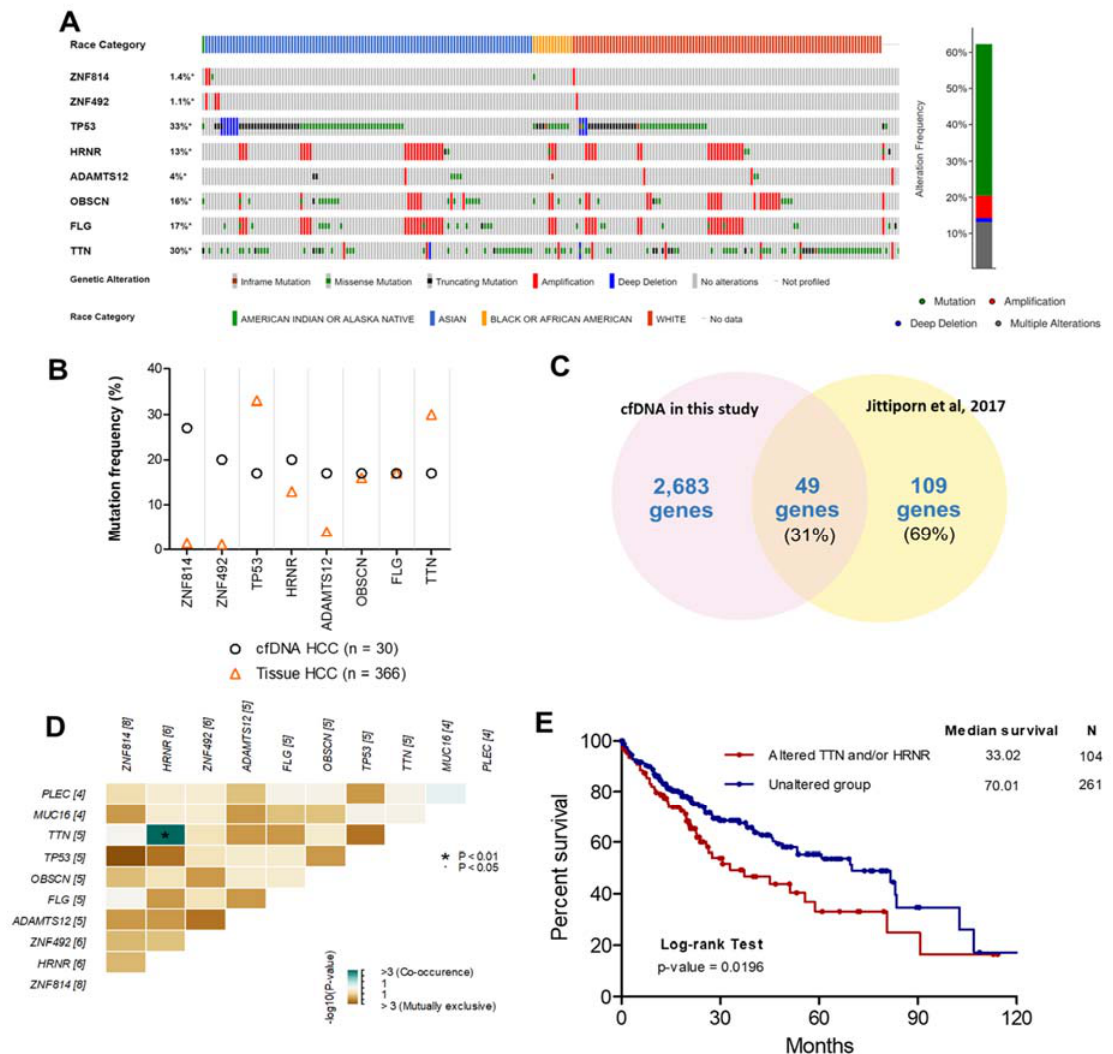
Figure 3. Comparison of the top eight frequently mutated genes from other studies. ( A ) Oncoprint of eight highly mutated genes in 366 HCC patients using the cBioPortal dataset ordered by the race of patients and type of genetic alteration. Far-right: alteration frequency (percentage) of patients with an alteration. ( B ) Comparison of mutation frequency between cfDNA in the present study and tissue DNA from the TCGA dataset. ( C ) Intersect of mutated genes between cfDNA in the present study and HCC tissue DNA from exome sequencing data (Thailand). Percentages are the proportion of mutated genes in HCC tissue DNA (Thailand). ( D ) Co-occurrence of 10 mutated genes. Green indicates a tendency toward co-occurrence. ( E ) Overall survival analysis of patients with HCC using the TCGA dataset for TTN and/or HRNR mutation.